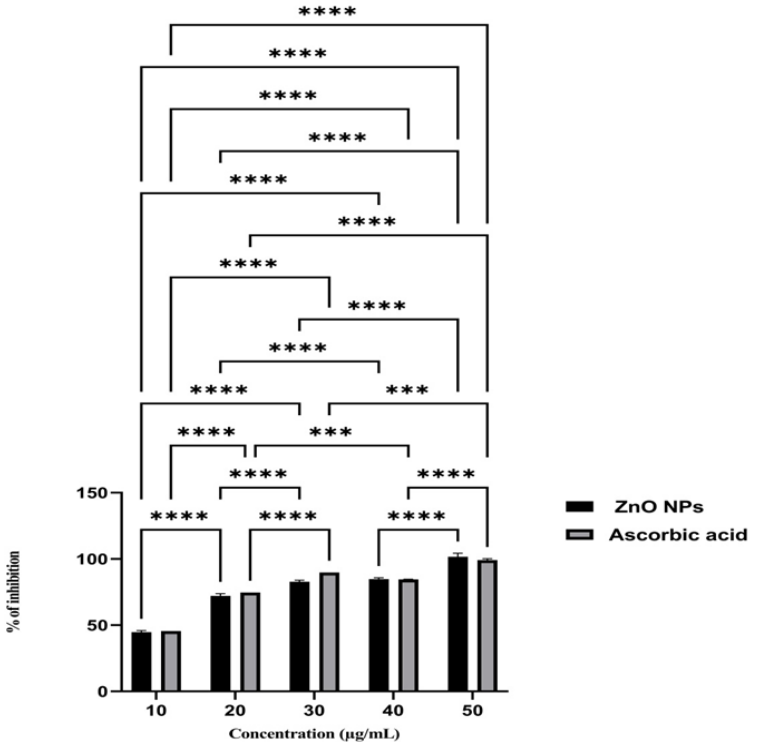
Figure 8. Antioxidant activity of ZnO NPs (ascorbic acid as a standard). Asterisks show a statistically significant difference (****— p ˂ 0.0001, ***— p ˂ 0.001).